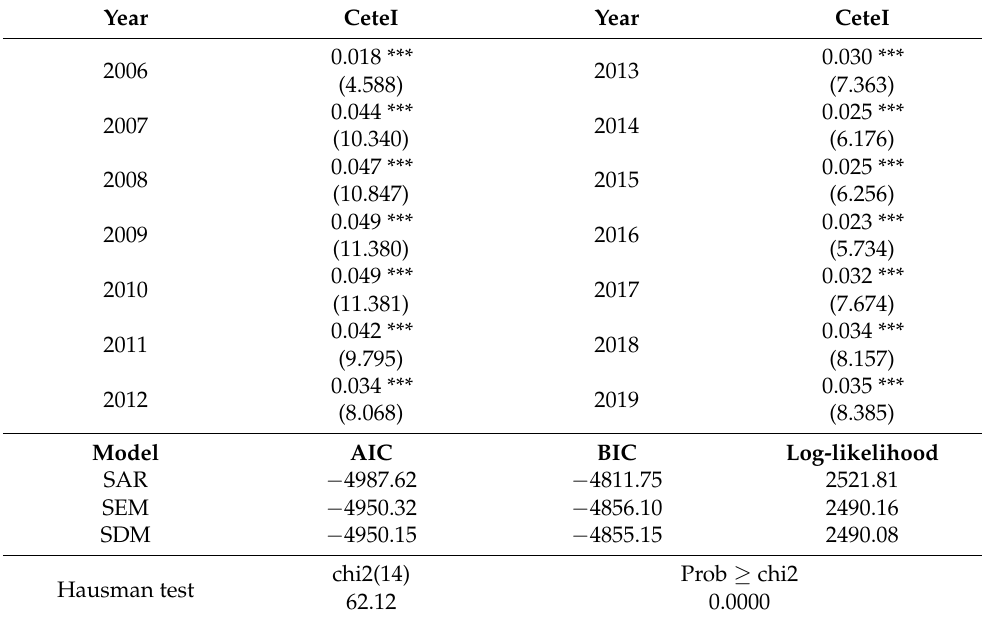
Table 3. Global Moran’s I of market segmentation, carbon performance, and model selection.